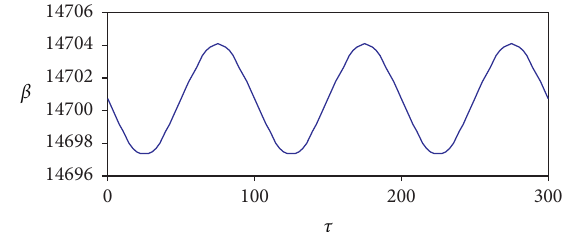
Figure 32: The analytical solution β for case (iv) in Section 4.2.